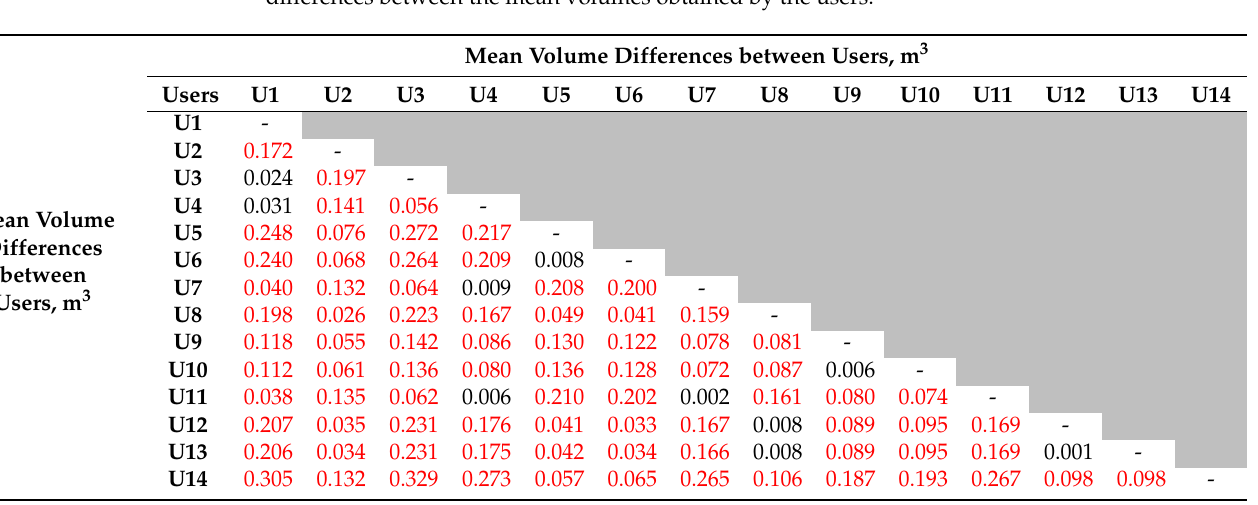
Table A7. Differences between mean partial volumes obtained by each user with Huber’s formula when a laser caliper was used to measure upper-stem diameters. The red values denote significant differences between the mean volumes obtained by the